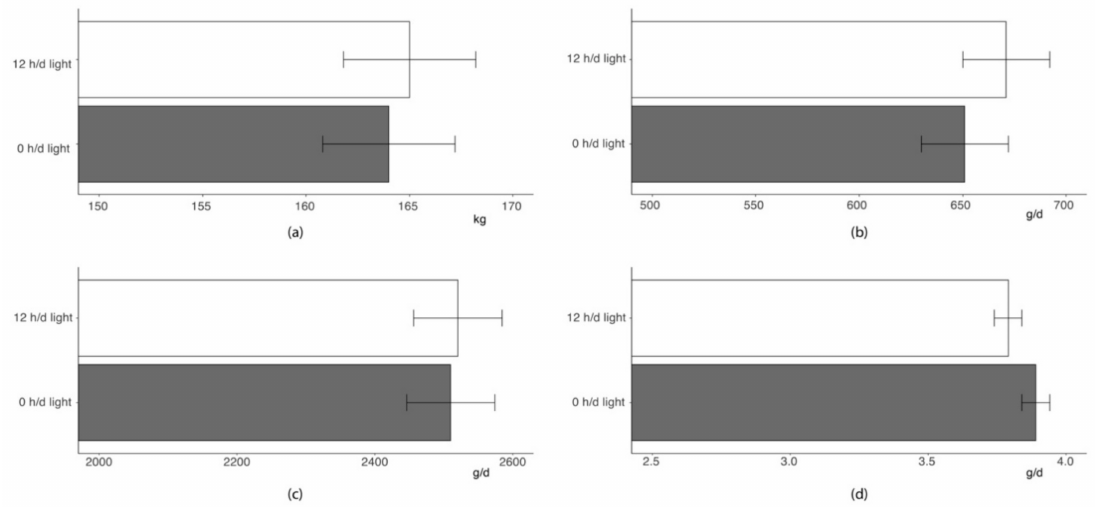
Figure 3. Least squares means of: ( a ) final BW, ( b ) overall average daily gain, ( c ) average daily feed intake, and ( d ) feed-to-gain ratio of pigs given 0 h (grey bar) or 12 h light daily (white bar) during the first 48 h after mixing ( p value of the di ff erences between means >